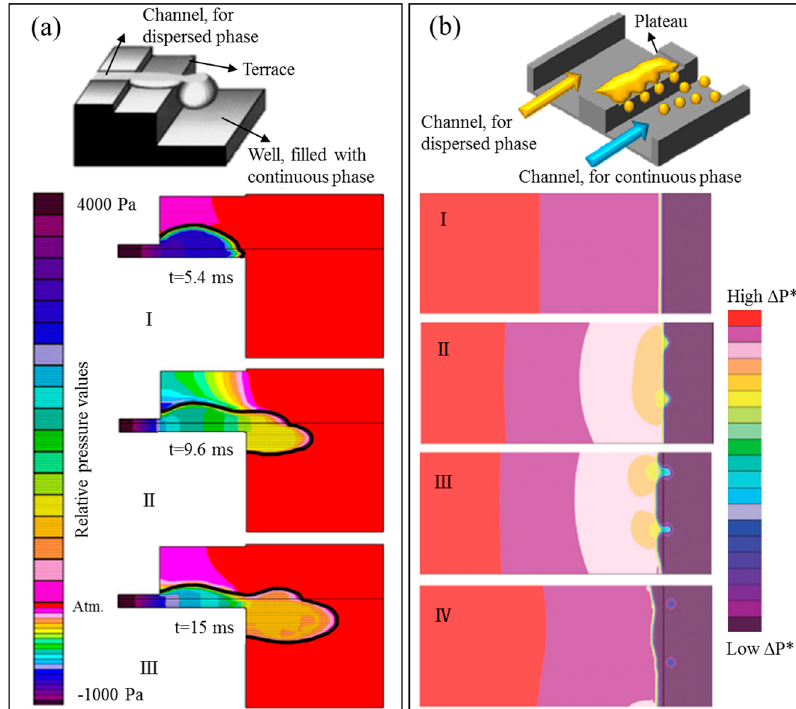
Figure 6. In ( a ), top: A forming droplet in the terrace-based MC system, adapted from Sugiura et al. (2002) [37] with permission from American Chemical Society; bottom: Half of the geometry of the MC system modeled to investigate the pressure gradient around the forming droplet at different time stages (I, II, and III) during emulsification, adapted from van Dijke et al. (2010) [38]. In ( b ), top: Droplet formation in an EDGE system, adapted from Sahin et al. (2016) [43]; bottom: Droplet formation on the plateau modeled from continuous phase filling the plateau, till the droplets are detached (I through IV), used to investigate the pressure gradient around forming droplets (light blue); adapted from van Dijke et al. (2010) [44] with permission from The Royal Society of Chemistry. In both systems, the pressure gradient near the droplet formation site becomes steeper with growing droplet size.